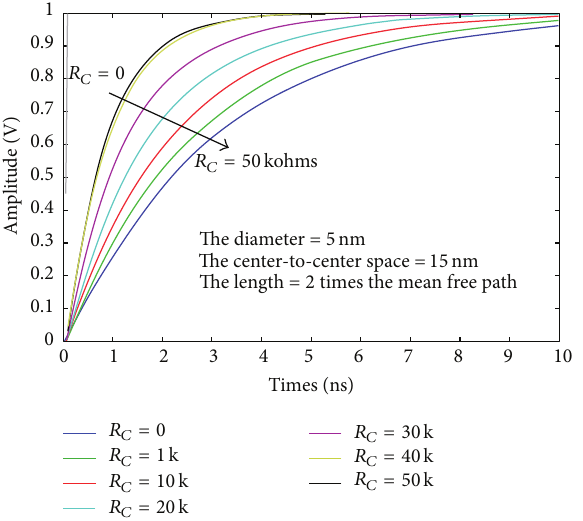
Figure 10: The output response of the configuration in Figure 5 to the ramp input with the slope of 10 V / ns, using (22), for various values of the contact resistance and with the switching factor 𝑘 = −1